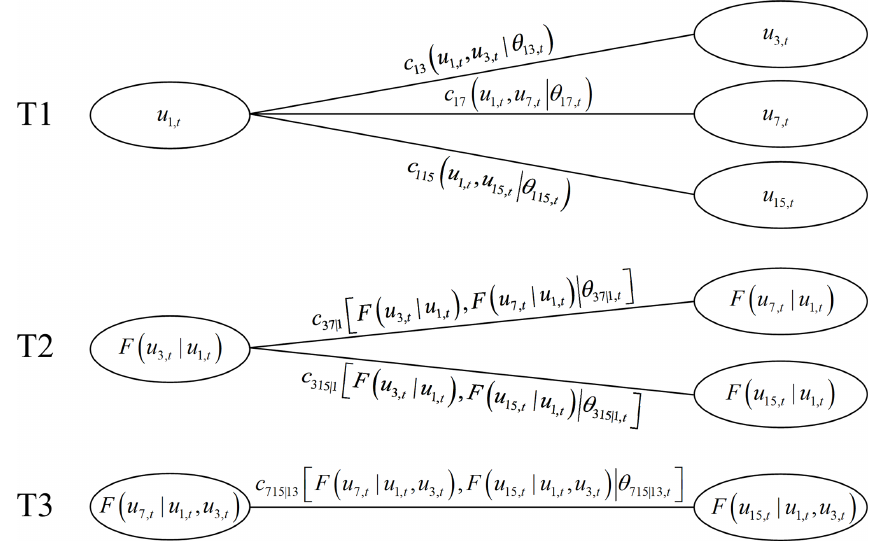
Figure 3. Decomposition of the four-dimensional C-vine copula.